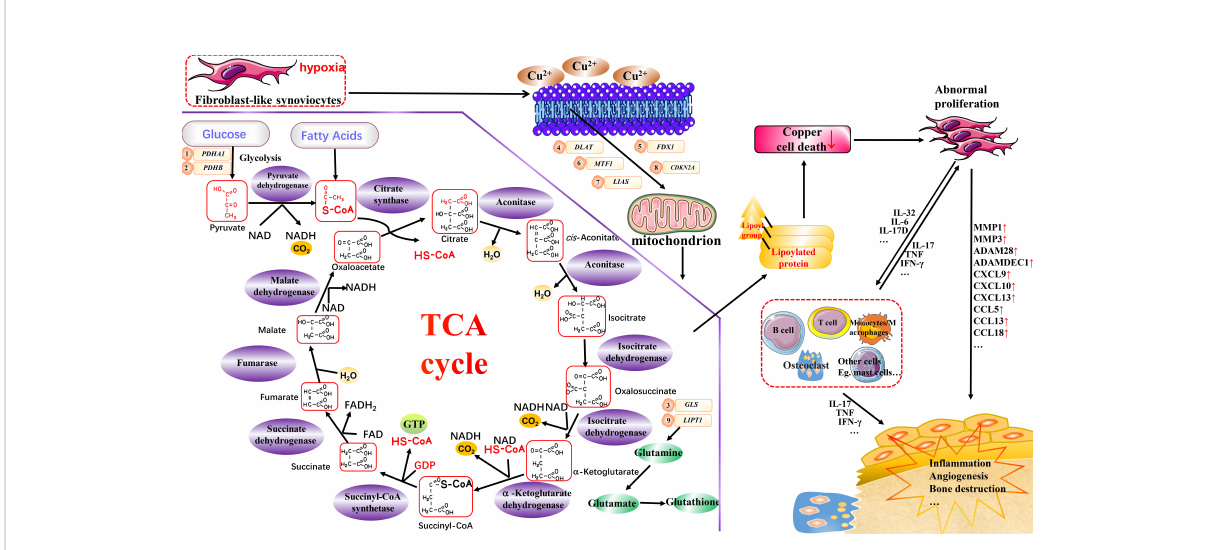
FIGURE 1 Potential association of cuproptosis and cuproptosis – related genes with RA. Copper can induce cuproptosis by binding to lipid-acylated TCA cycle components, promoting lipid-acylated protein aggregation, and inducing protein stress. This may affect various cells in RA, such as FLS and monocytes/macrophages, thereby aiding in in fl ammation, angiogenesis, and the bone destruction processes. Vital regulatory genes for cuproptosis are potentially linked to RA through distinct biological functions. However, the speci fi c mechanisms require further